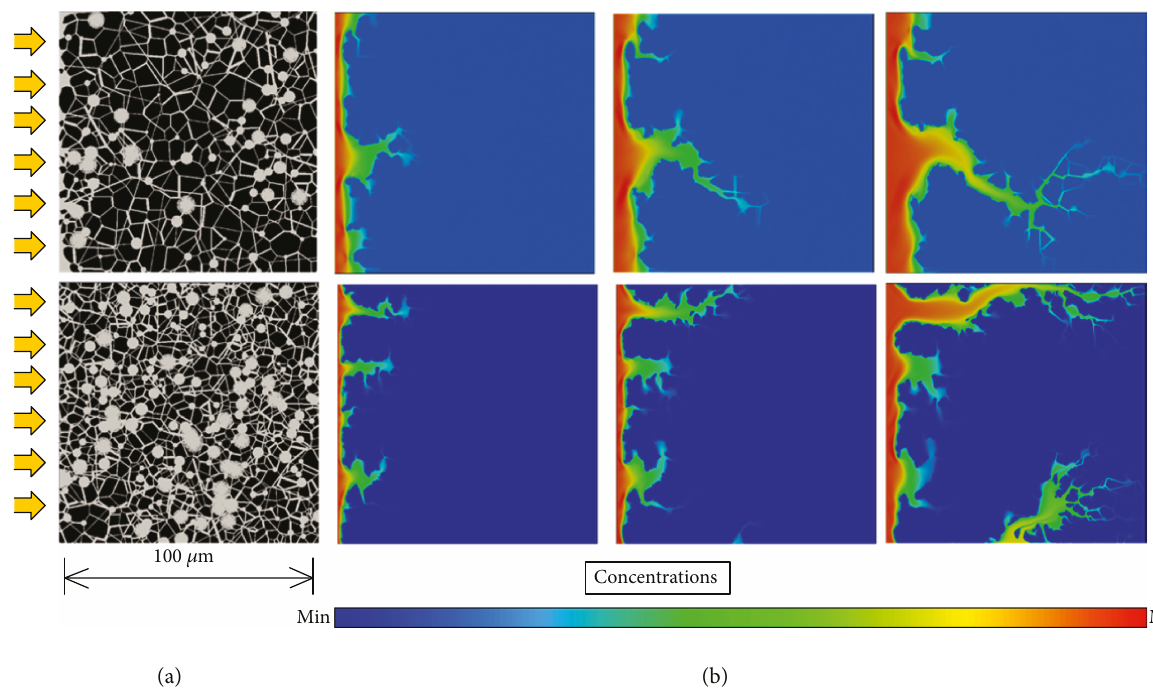
Figure 4: (a) Initial pristine pore structures with porosity 0.25 (top) and 0.39 (bottom), black is solid, gray is void. From (a) to (b), temporal evolution for the high Pe = 400 -high Da = 87 × 10 5 boundary condition leading to the creation of wormholes. Contour gradient of the reactant concentration is